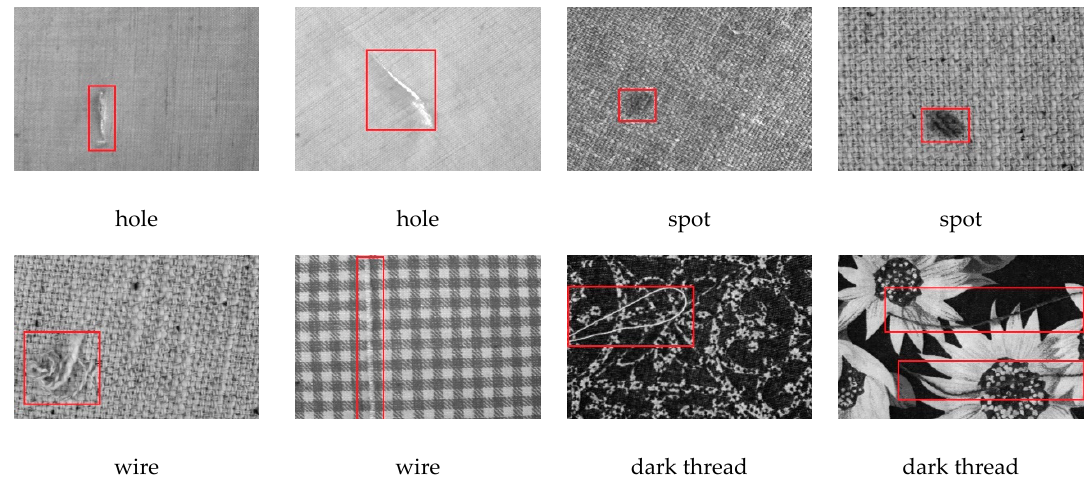
Figure 7. Illustration of defect images on TILDA dataset.